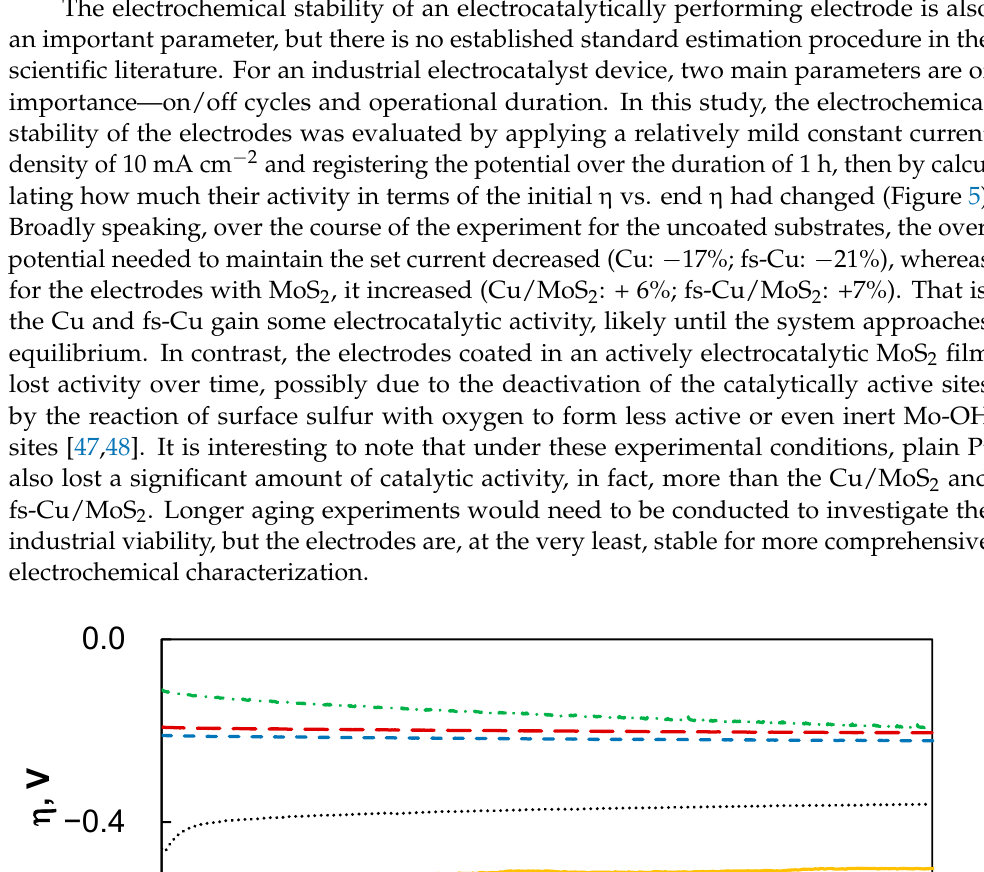
Table 3. The comparison of the reported Tafel slopes and overpotentials at the 10 mA cm − 2 HER